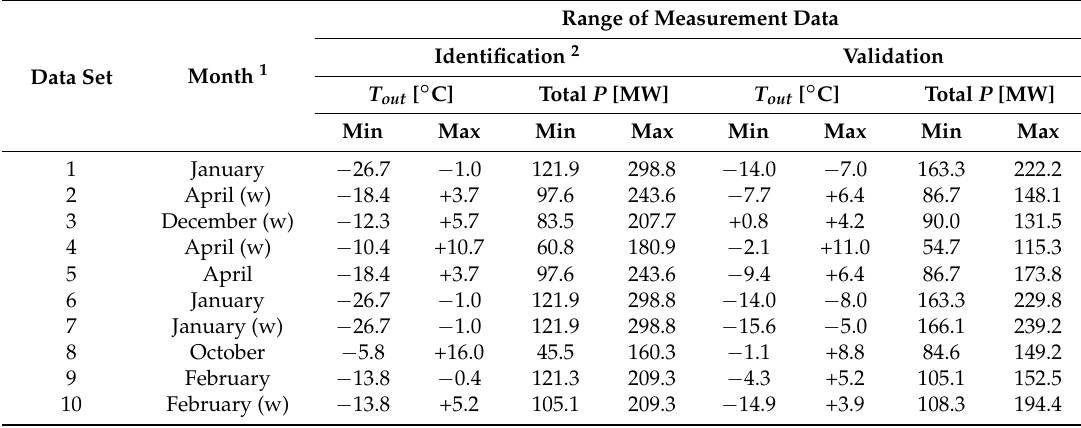
Table 1. Data sets for the heat demand forecast with the range of measurement data presented for both the identification data and the validation